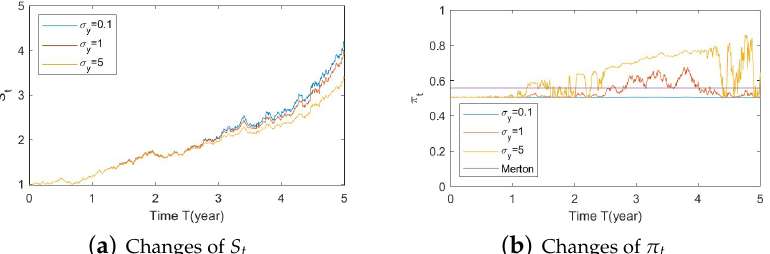
Figure A20. Illustrate the impact on ( a ) stock prices and ( b ) optimal stock allocations when varying θ y ( e . g ., θ y = − 1,0,1 ) .